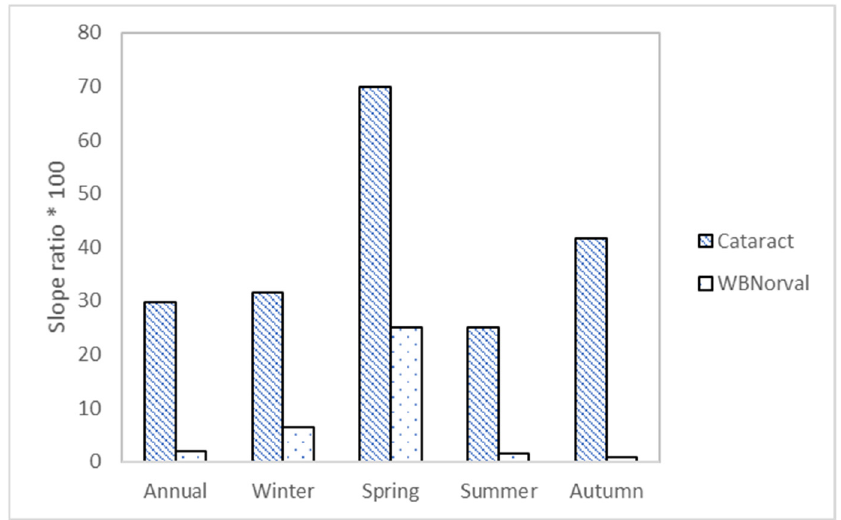
Figure 11. Cataract and WB Norval annual and seasonal streamflow changes normalized (for com- parison) with the temperature for the period 1971–2019. The Cataract (rural) gauge shows a greater increase in streamflow.